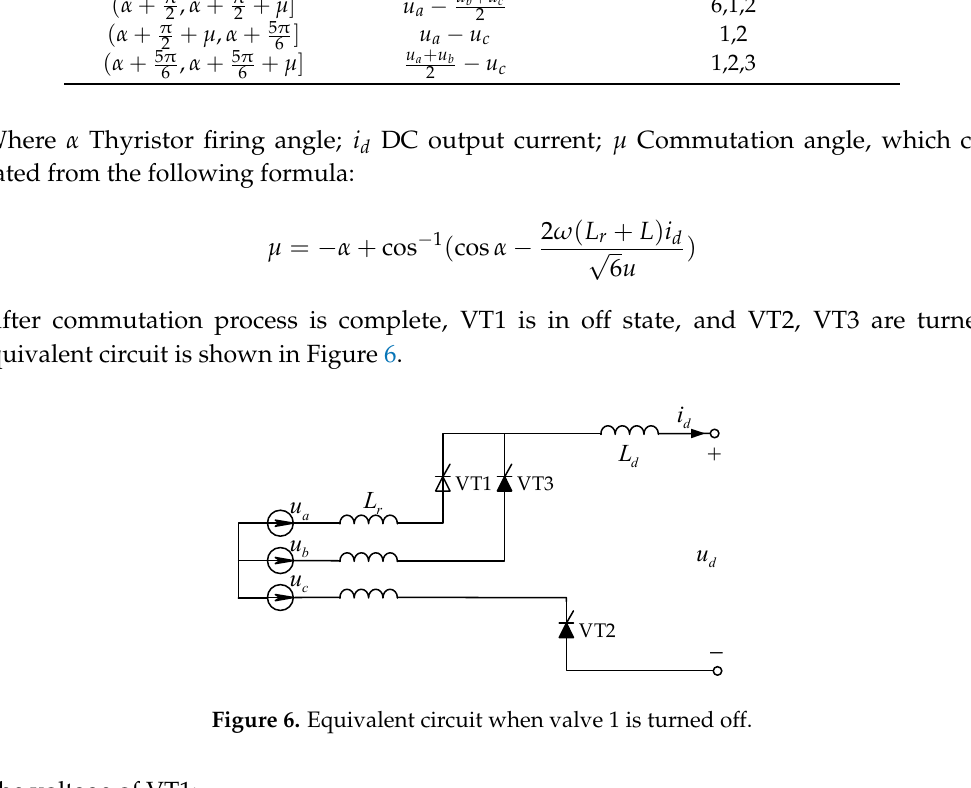
Table 1. DC output voltage of L/C switch equivalent circuit.